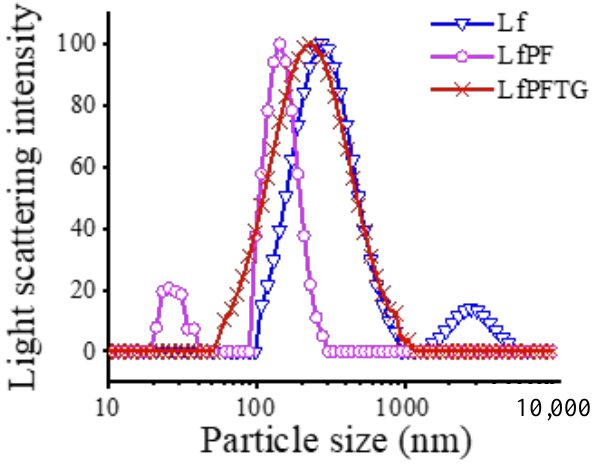
Figure 2. Particle size distributions of bLf, LfPF complex, and LfPFTG